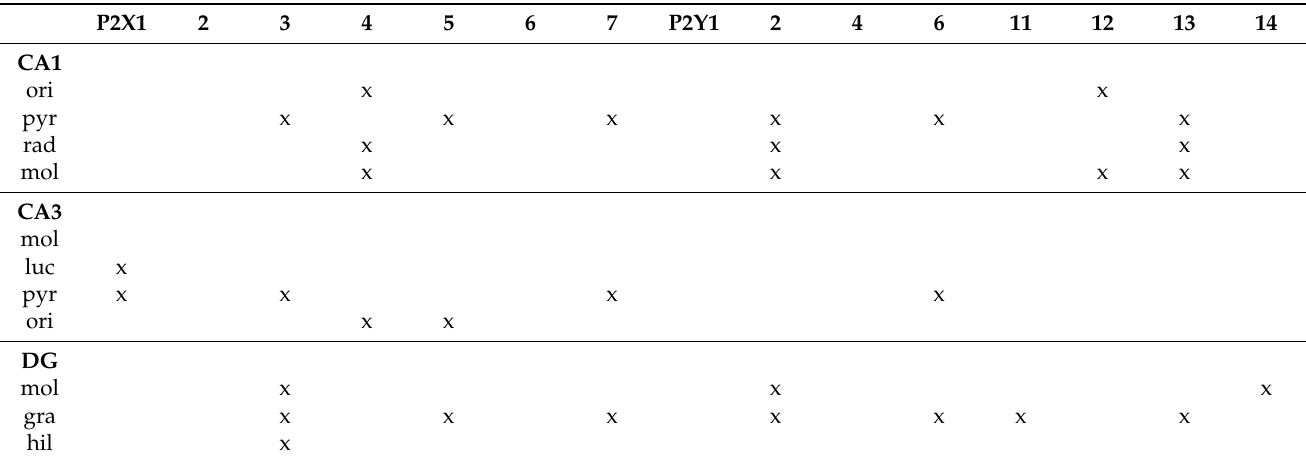
Table 2. Time-of-day- dependent P2 receptor expression in hippocampal